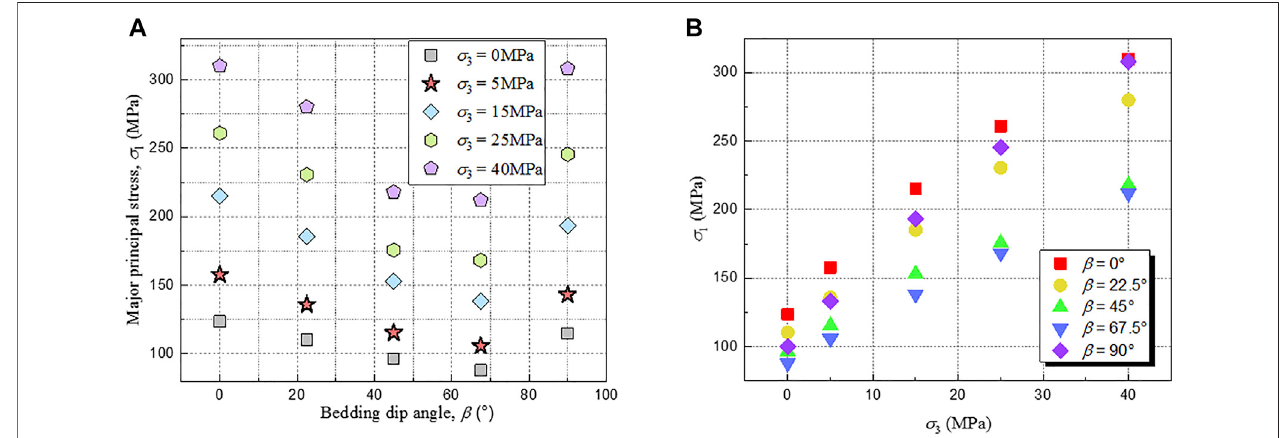
FIGURE 6 | Experimental data of compressive strength of bedded rock. (A) Strength of specimens with different bedding dip angles under the same con fi ning pressure; (B) strength of specimens with the same bedding dip angle under different con fi ning pressure.